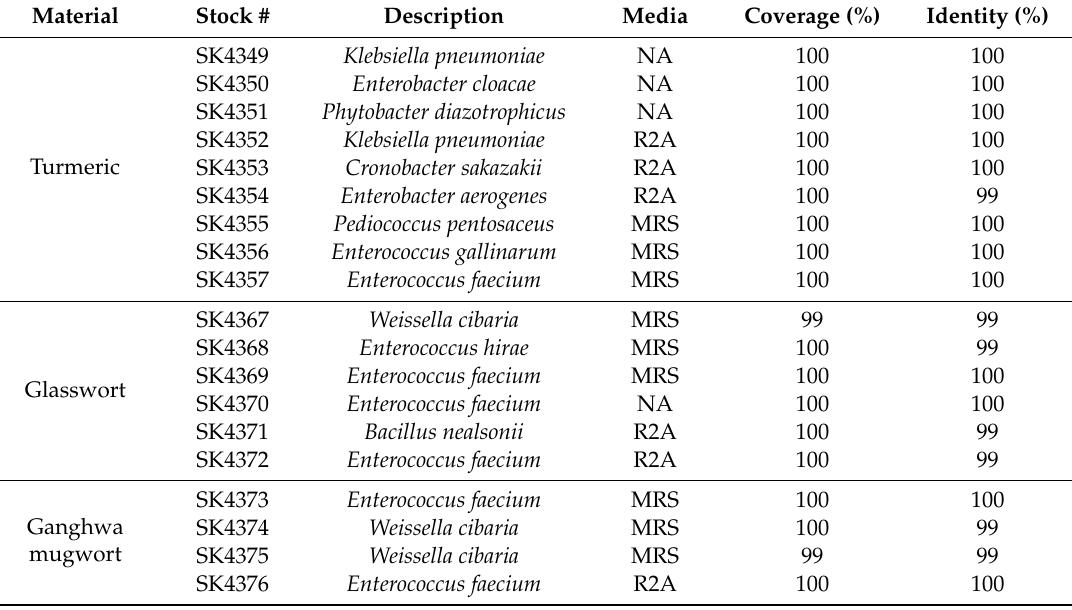
Table 2. Isolation and identification of microorganisms from medicinal plants used in this study.